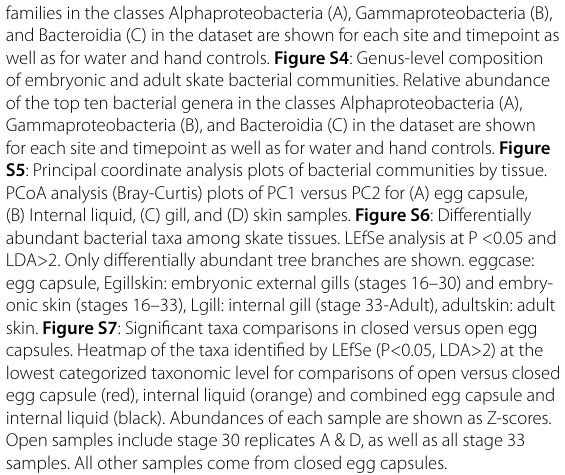
skin. Figure S7 : Significant taxa comparisons in closed versus open egg capsules. Heatmap of the taxa identified by LEfSe (P<0.05, LDA>2) at the lowest categorized taxonomic level for comparisons of open versus closed egg capsule (red), internal liquid (orange) and combined egg capsule and internal liquid (black). Abundances of each sample are shown as Z-scores. Open samples include stage 30 replicates A & D, as well as all stage 33 samples. All other samples come from closed egg